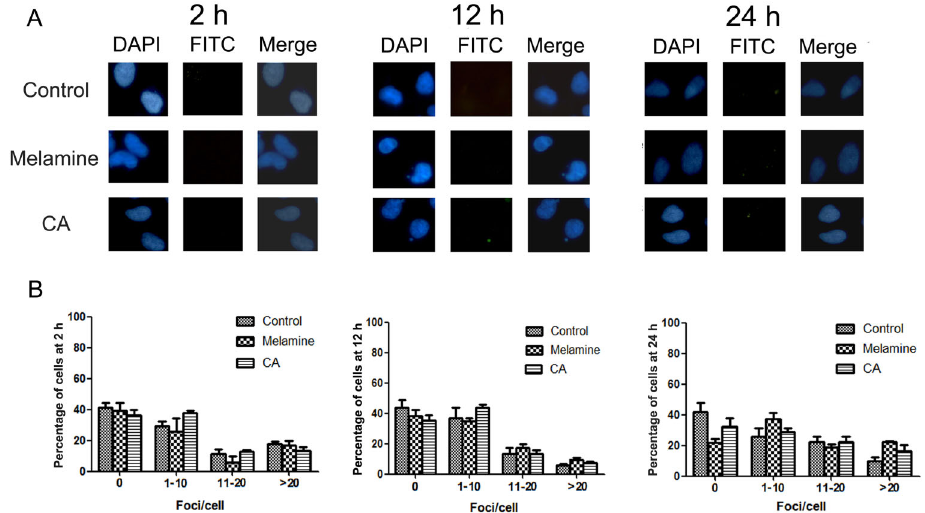
Figure 2. Neither melamine nor cyanuric acid (CA) alone induced phosphorylated-H2AX ( g H2AX) foci formation in 293 cells. After melamine or CA treatment for 2, 12, and 24 h, cells were fi xed and stained with anti - g H2AX antibody and subjected to immuno fl uorescent microscopy. A , Representative images from 1 of 4 independent experiments. Upper panel, control; middle panel, melamine-treated cells; lower panel, CA-treated cells. Blue, 4,6 - diamidino - 2 - phenylindole (DAPI) stain for nuclei; fl uorescein isothiocyanate (FITC), green stain for g H2AX. B , Semi - quanti fi cation of g H2AX-positive cells from ( A ). Data are reported as means ± SD.